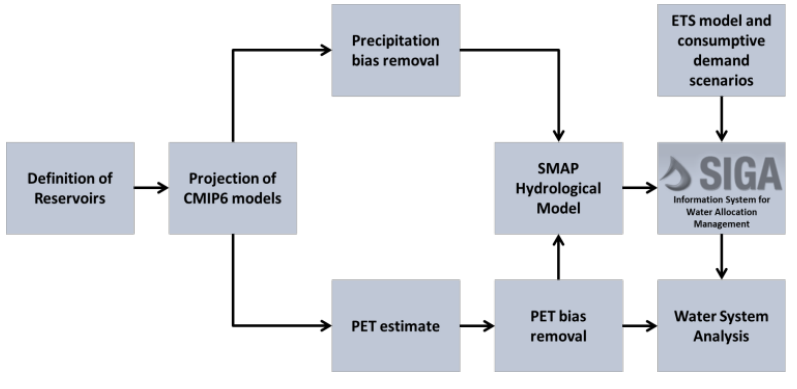
Figure 1. Methodological Steps.